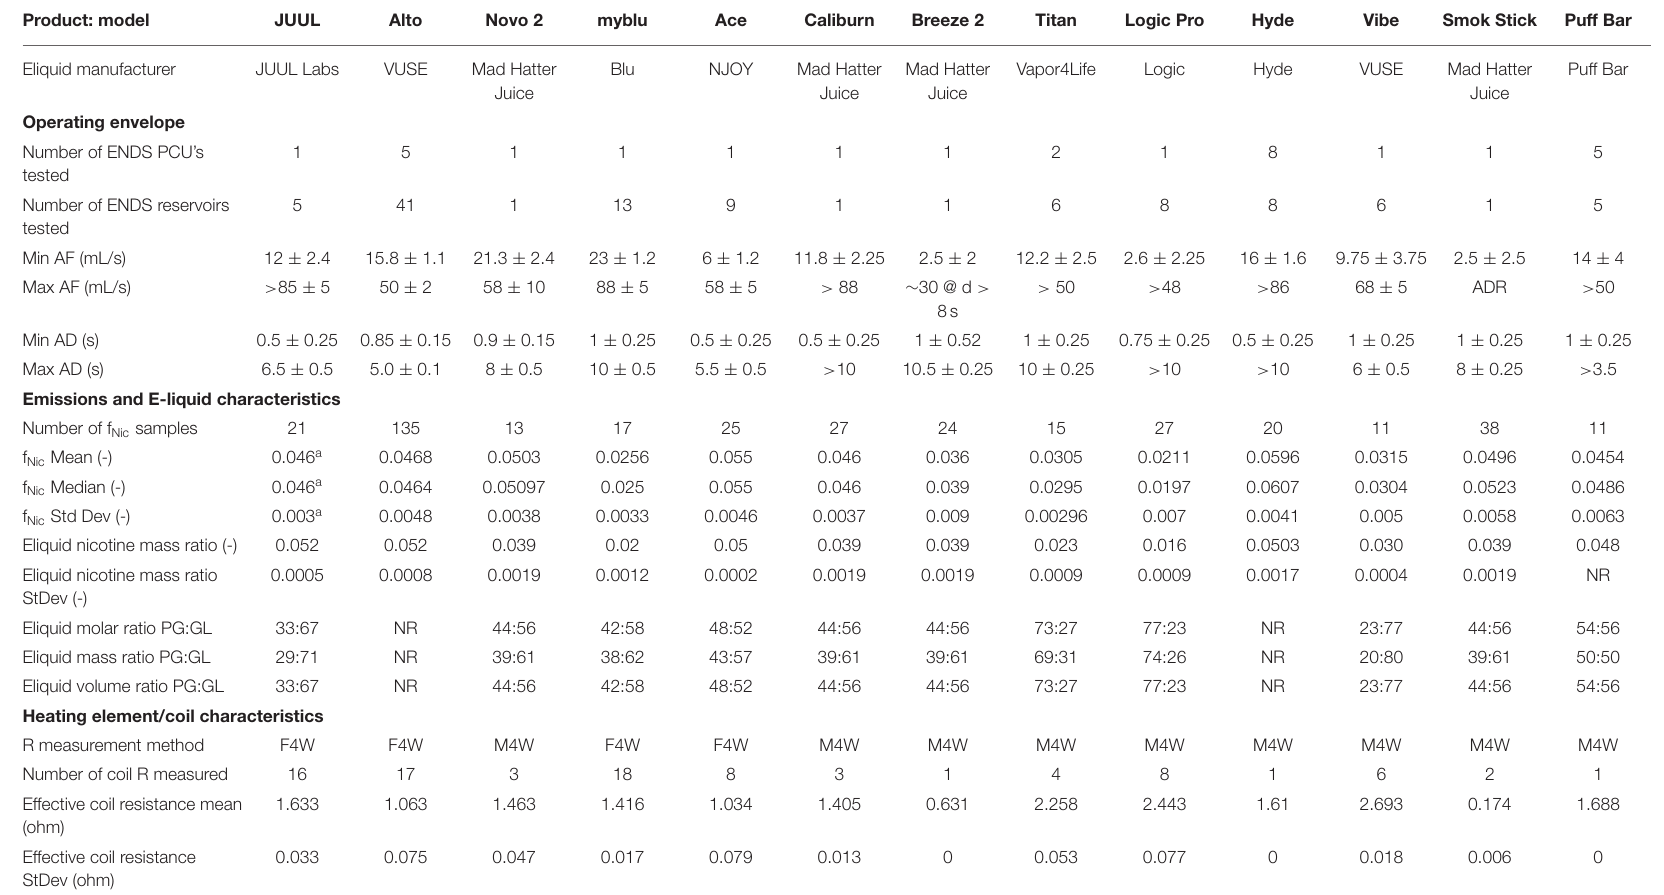
TABLE 2 | Nominal operating envelope and emissions characteristics of test specimens used in this